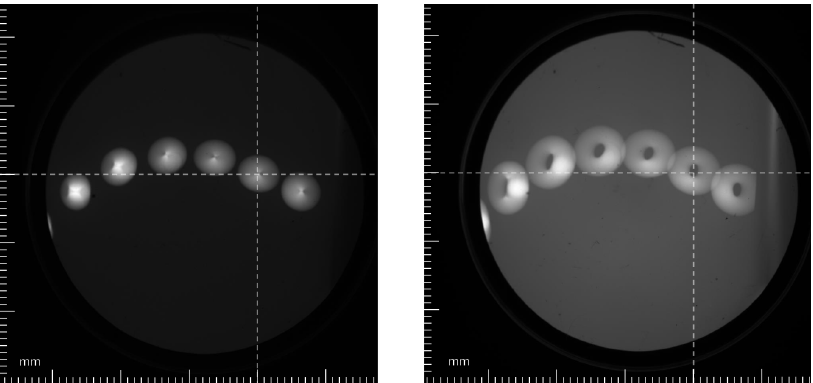
Figure 10. Observed camera image of the six beam spots beyond the aperture in the Setup 2 configuration with the lens on at a current through the coils of 28A, left and 33A, right. Both images were taken with a lens voltage of 20kV. An additional spot is visible on the left hand side, as the lens focusing is increased. The dashed lines indicate the beam